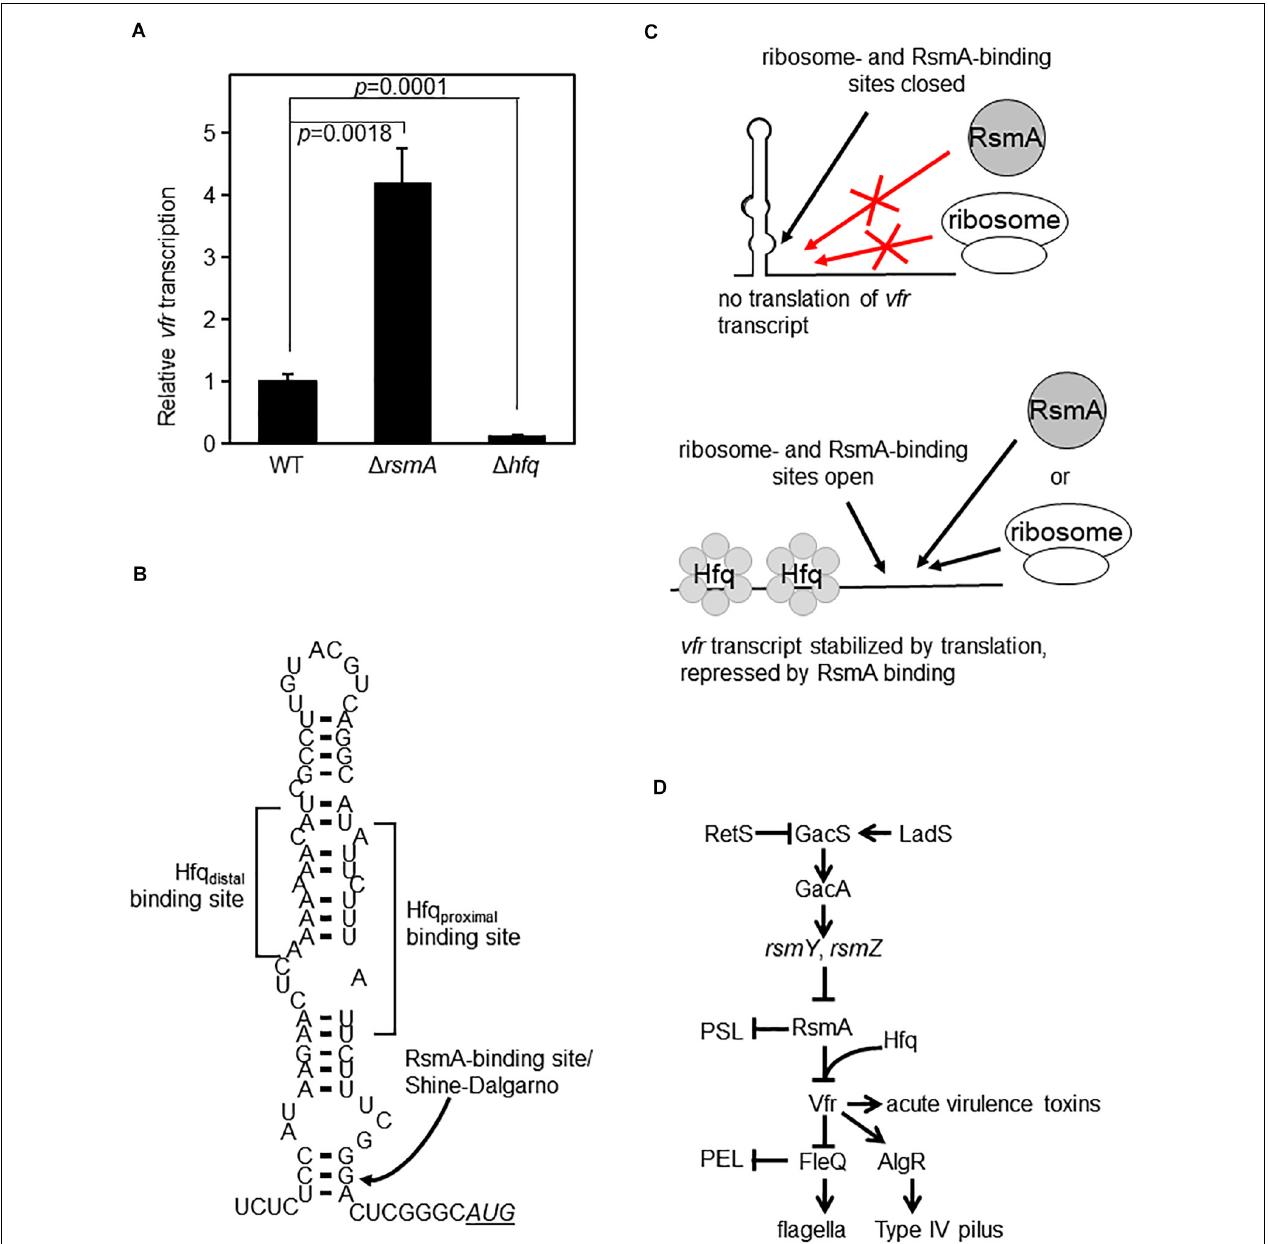
FIGURE 5 | Hfq and RsmA affect vfr expression. (A) Single-copy transcriptional lacZ fusion constructs show that vfr transcript levels are increased in the (cid:49) rsmA background (as in Figure 1C ) but are essentially abolished in the (cid:49) hfq mutant background. The y -axis values are expressed as relative to WT as 1. (B) RNA secondary structure of the leader sequence region of vfr as predicted by mFOLD (Zuker, 1989, 2003). The locations of in silico -detected Hfq- and RsmA-binding sites are indicated. Note that the RsmA-binding site located at the base of the stem-loop structure overlaps with the Shine–Dalgarno sequence of the ribosome binding site. The AUG start codon is shown in underlined italics. (C) Schematic illustration of a model for Hfq- and RsmA-mediated regulation of vfr . In the absence of Hfq, the stem-loop structure shown in panel (B) blocks binding of both RsmA and ribosomes, resulting in a decrease of vfr expression as seen in panel (A) . Upon Hfq binding of vfr RNA, the stem-loop structure shown in panel (B) is disrupted, exposing the ribosome- and RsmA-binding sites. RsmA-binding then directly blocks the Shine–Dalgarno sequence, preventing ribosome access and thereby inhibiting translation. In vivo , the untranslated vfr mRNAs are presumed to be subsequently rapidly processed for degradation. (D) Simplified overview of the Gac/Rsm pathway that controls RsmA levels and pertinent parts of its downstream regulon.